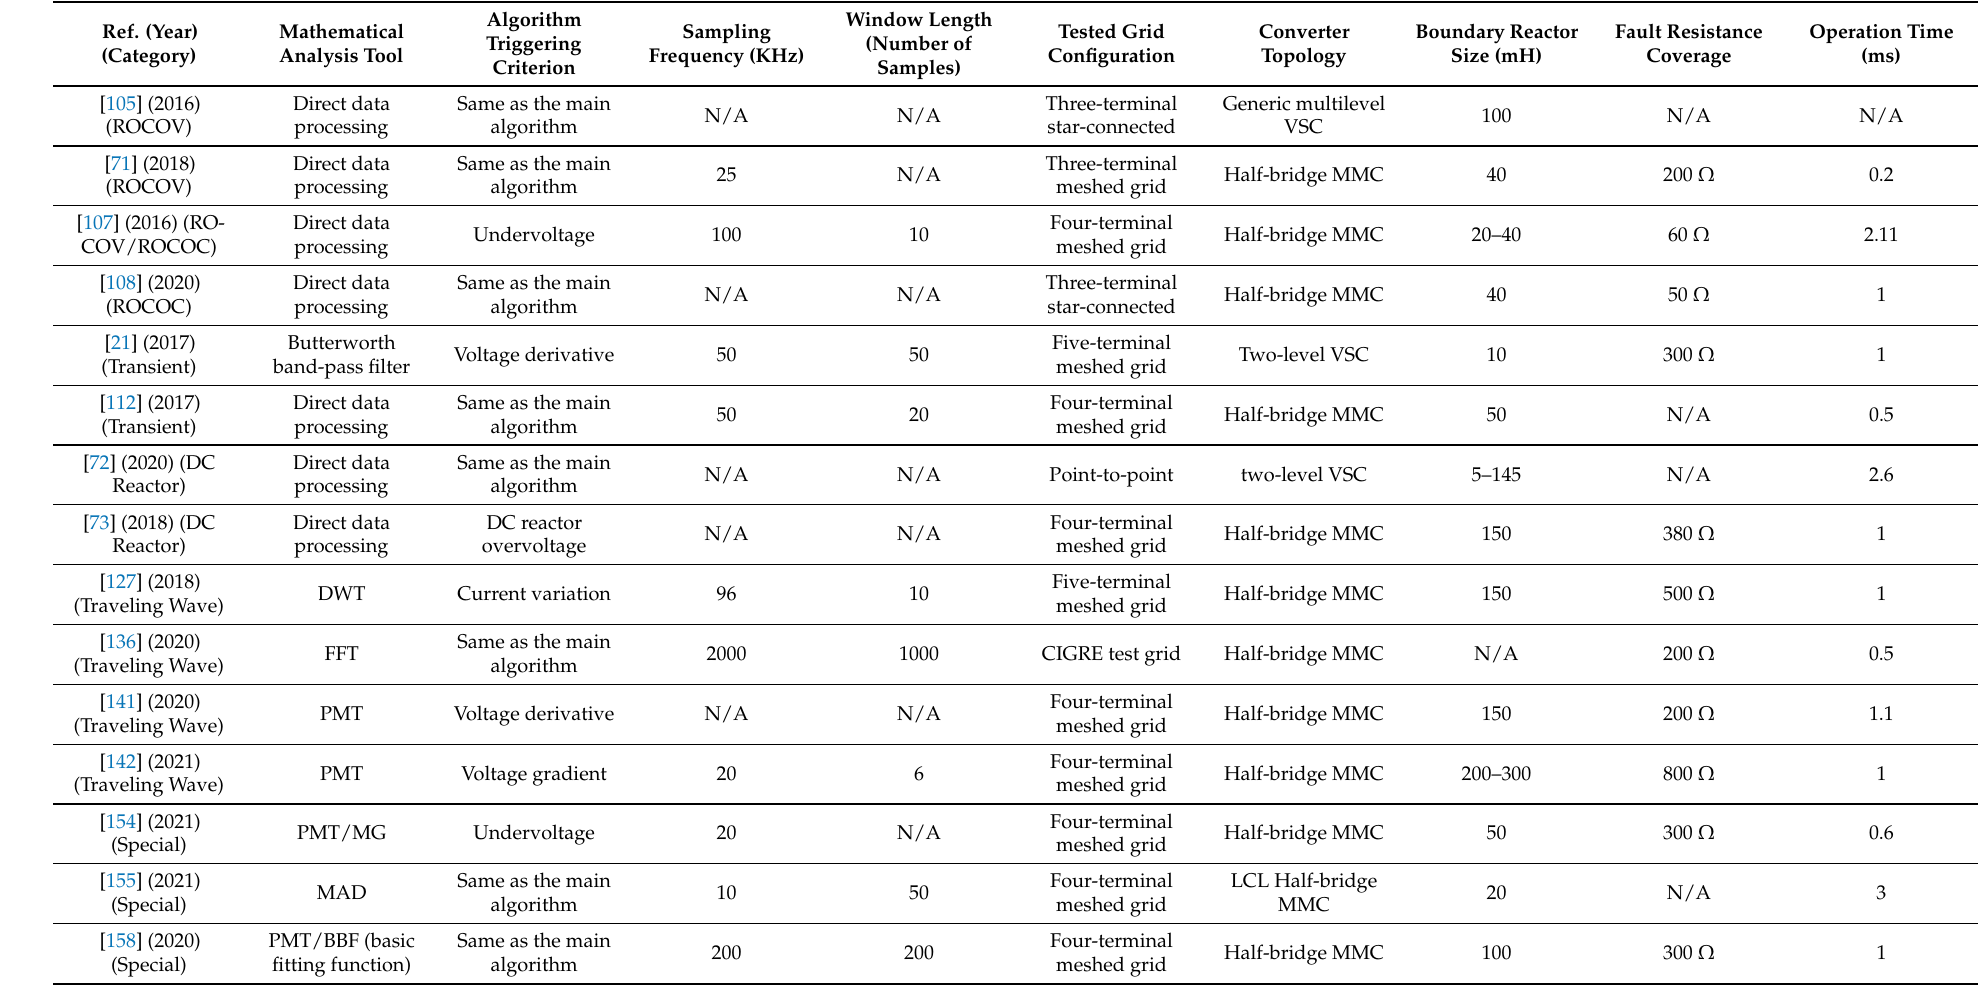
Table 5. Comparison among communication-less protection